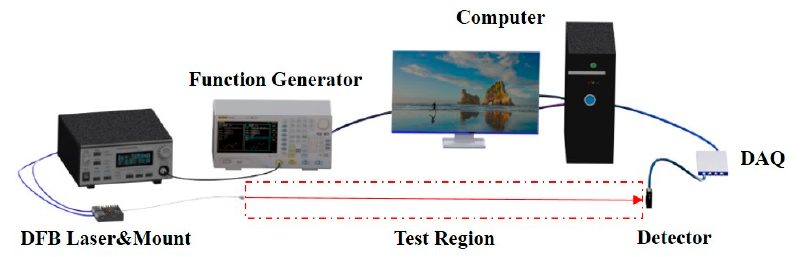
Figure 2. The schematic of the experimental setup.